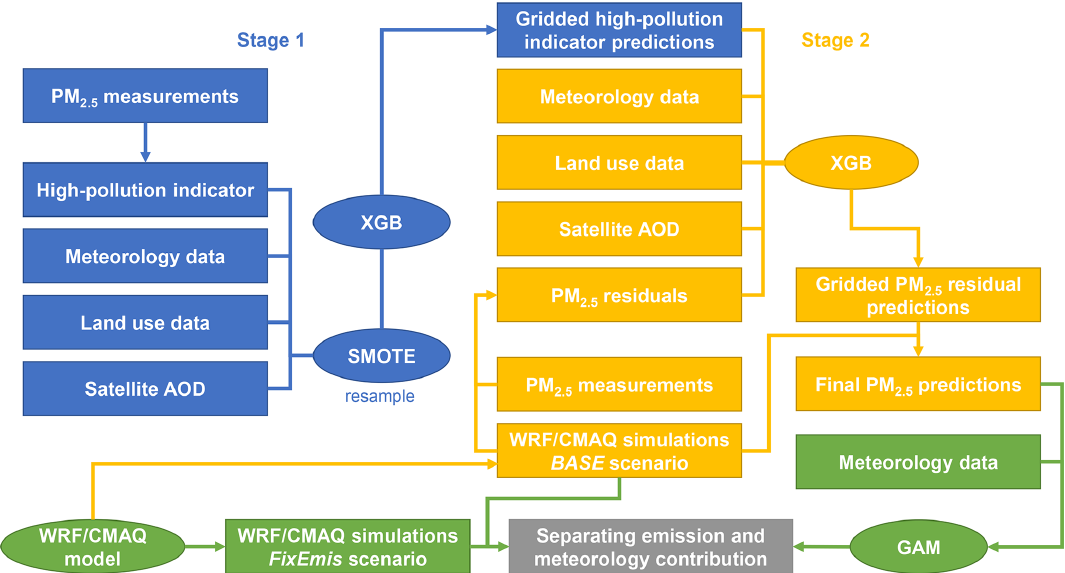
Figure 1. Methodology framework of this study. The green process shows the two methods that separate emission and meteorology contri- butions to PM 2 . 5 in this study. The first method assesses the meteorology-associated PM 2 . 5 from WRF/CMAQ simulations with the fixed emissions at the 2000 level and varying meteorological inputs. The second method assesses the meteorology-associated PM 2 . 5 with satellite- based PM 2 . 5 estimations and a generalized additive model (GAM). The processing of satellite-based PM 2 . 5 estimation includes two stages. In stage 1 (blue), we constructed a measurement-based high-pollution indicator and trained an extreme gradient boosting (XGB) model to predict the high-pollution indicator. In stage 2 (yellow), we trained a XGB model to predict the residuals of WRF/CMAQ simulations with high-pollution indicator as well as satellite AOD, meteorology, and land use data as